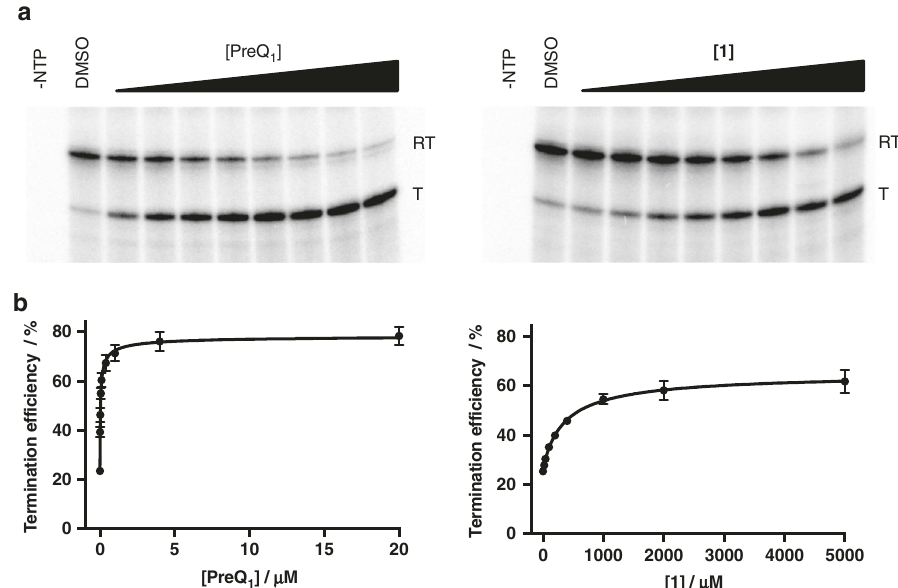
Fig. 5 Transcription termination assay of 1 . a Representative gel images of the 32 P-labeled RNA products of in vitro transcription of the Ss PreQ 1 -RS template in the presence of increasing concentrations of PreQ 1 (left) and 1 (right). Bands corresponding to the read-through transcription product (RT) and terminated transcription product (T) are indicated. Full gel images are provided in the Supplementary Information. b Quanti fi cation of transcription termination ef fi ciency of increasing concentrations of PreQ 1 (left) or 1 (right). Error bars indicate standard deviation, n = 3. Source data are provided